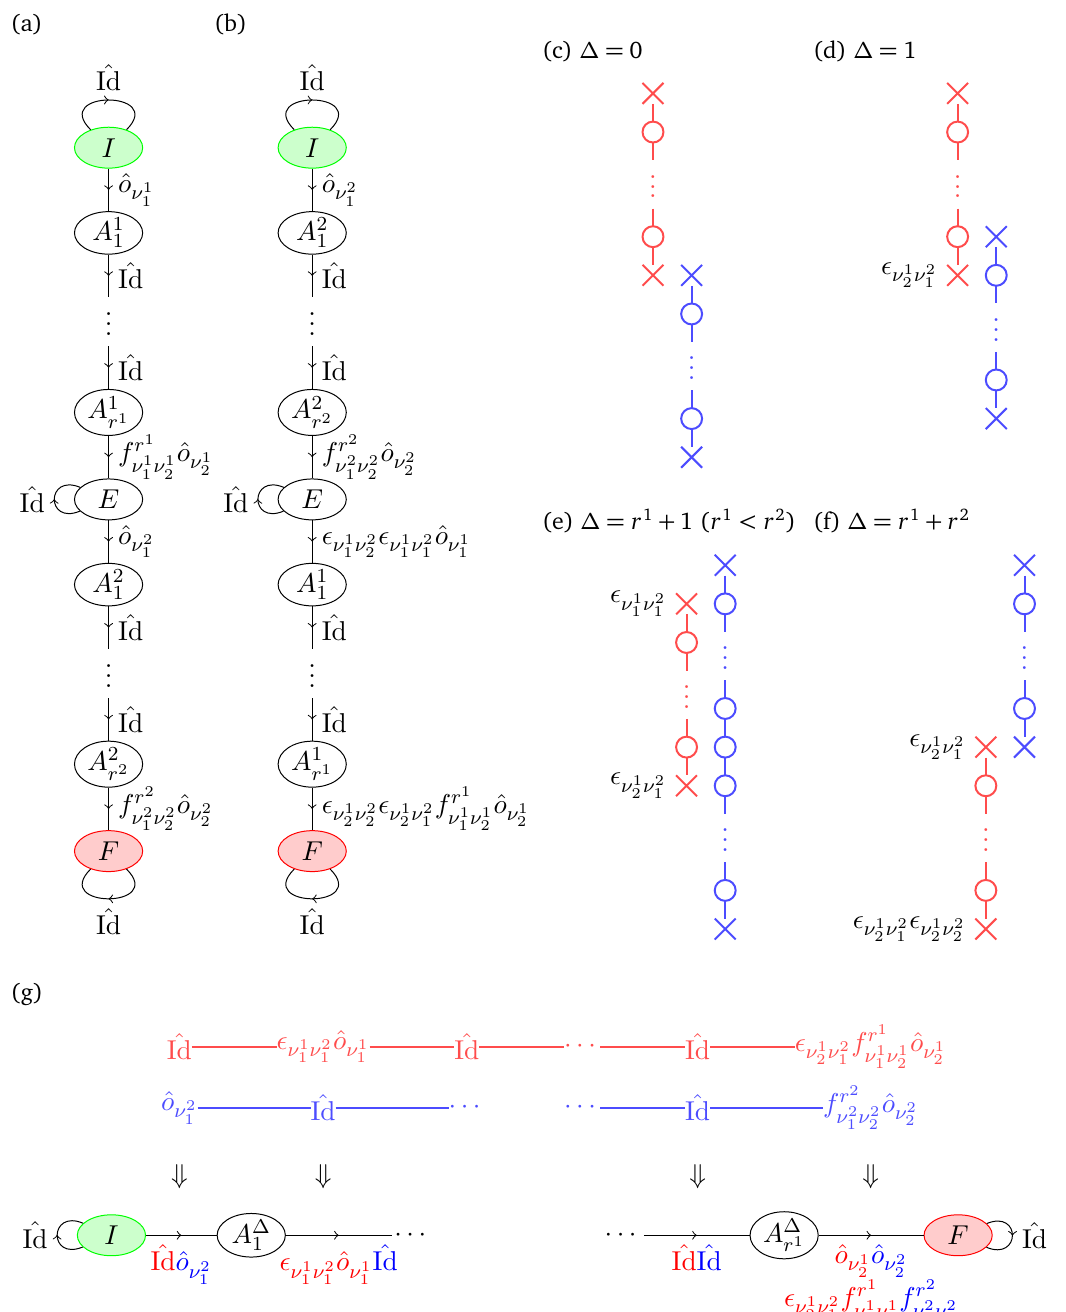
. (b) Tree diagram representation of ˆ H A ( i ) 2 by ∆ steps up until its terminating local operator is aligned ν 2 ν 2 , r 2 1 2 ( i ) 2 at step ∆ = r 1 + r 2 . (g) ν 1 ν 1 , r 1 1 2 f r 1 f r 2 ˆ o ν 1 ˆ o ν 2 , which is generated by the graph ν 1 ν 2 ν 2 ν 2 ν 1 ν 1 2 2 1 2 1 2 1 2